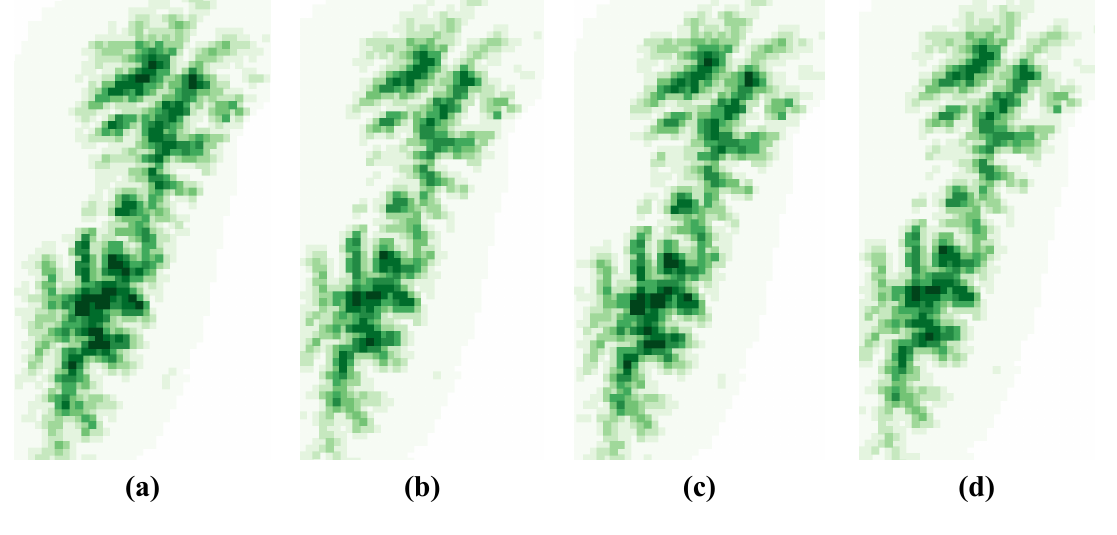
Figure 4. Predicted habitat suitability in Central Mountain Range area for Tsuga in 12 future scenarios (3 GES × 2 GCM × 2 parameter) for